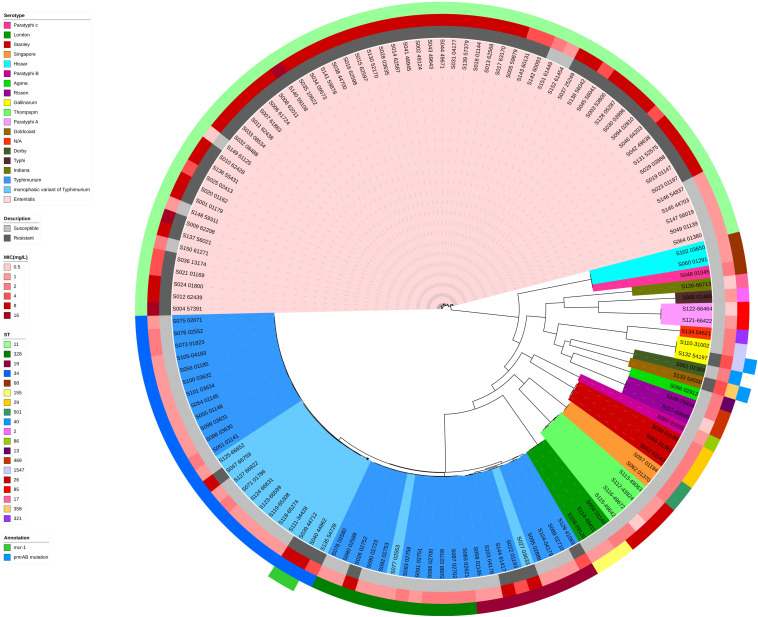
Maximum parsimony tree of the whole-genome sequenced 136 clinical Salmonella isolates. MICs (mg/L) and sequence types of colistin among different serotype Salmonella isolates were shown. Maximum parsimony tree were generated based on core-genome SNPs by kSNP 3.0. Isolates with different serotypes are indicated in the inner ring with different colors. Colistin MICs in mg/L are shown, along with corresponding mcr-1 gene and pmrAB mutations known to be associated with phenotypic resistance. For the description of colistin susceptibility, resistance corresponds to MIC > 2 mg/L and susceptible corresponds to MIC ≤ 2 mg/L.